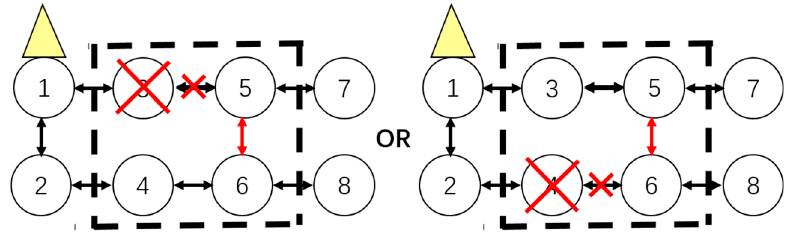
Figure 7. Situation of Route Adjustment.